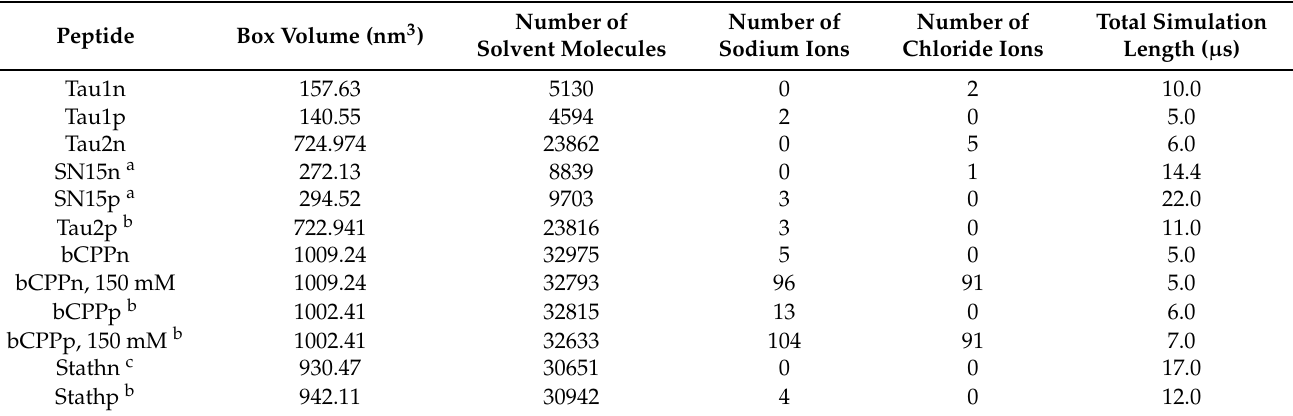
Table 8. Details of the simulations included in this work. The suffix n stands for non-phosphorylated peptide, while the suffix p stands for